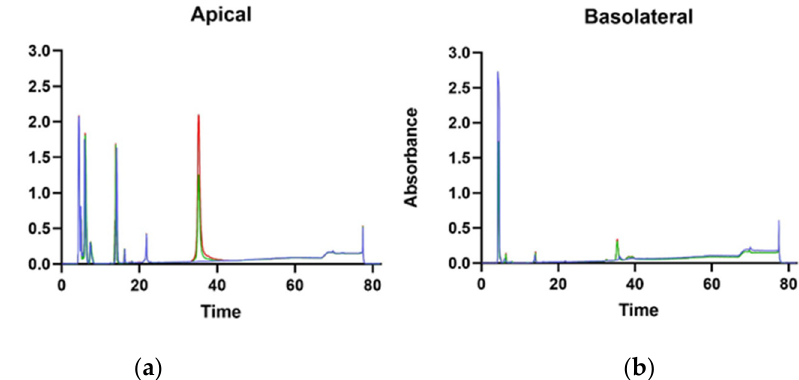
Figure 7. HPLC of supernatant from apical ( a ) and basolateral ( b ) chambers of transwell insert. Blue lines, red lines, and green lines indicate untreated, γ -C100 (1.00 mg/mL of γ -C), and γ -C50 (0.50 mg/mL of γ -C) samples, respectively.